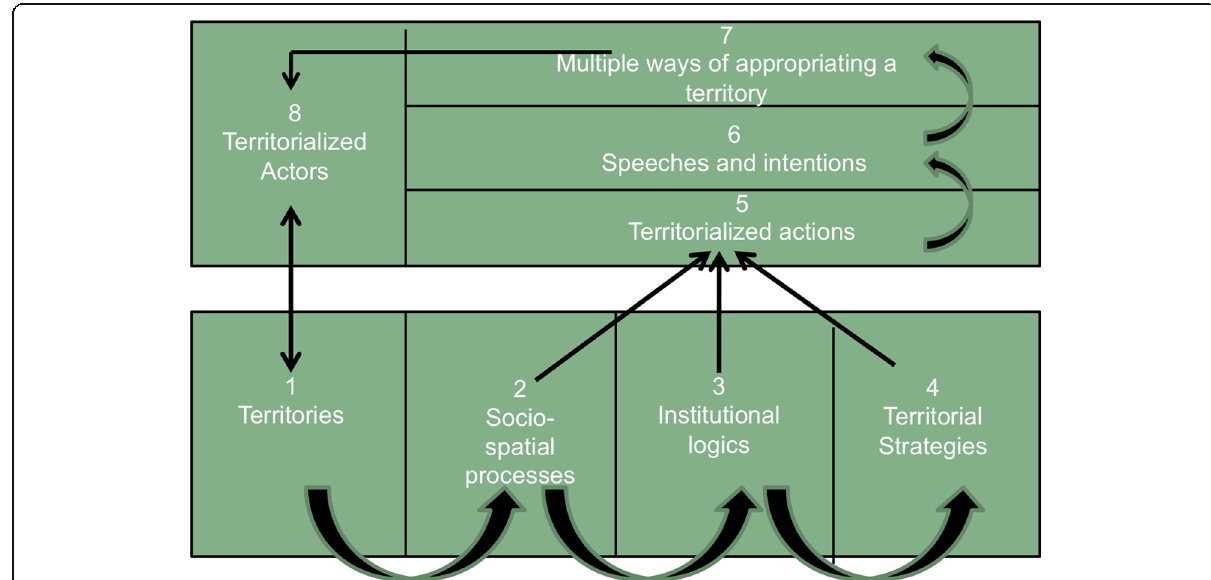
Fig. 2 Territorialized Actor Scheme (adapted from Gumuchian et al. (2003). Les acteurs, ces oublies du territoire.